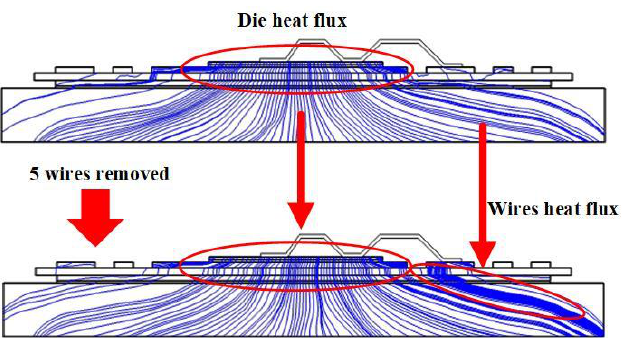
Figure 9. Sectional drawing of the heat flow in IGBT module with and without wires removed.